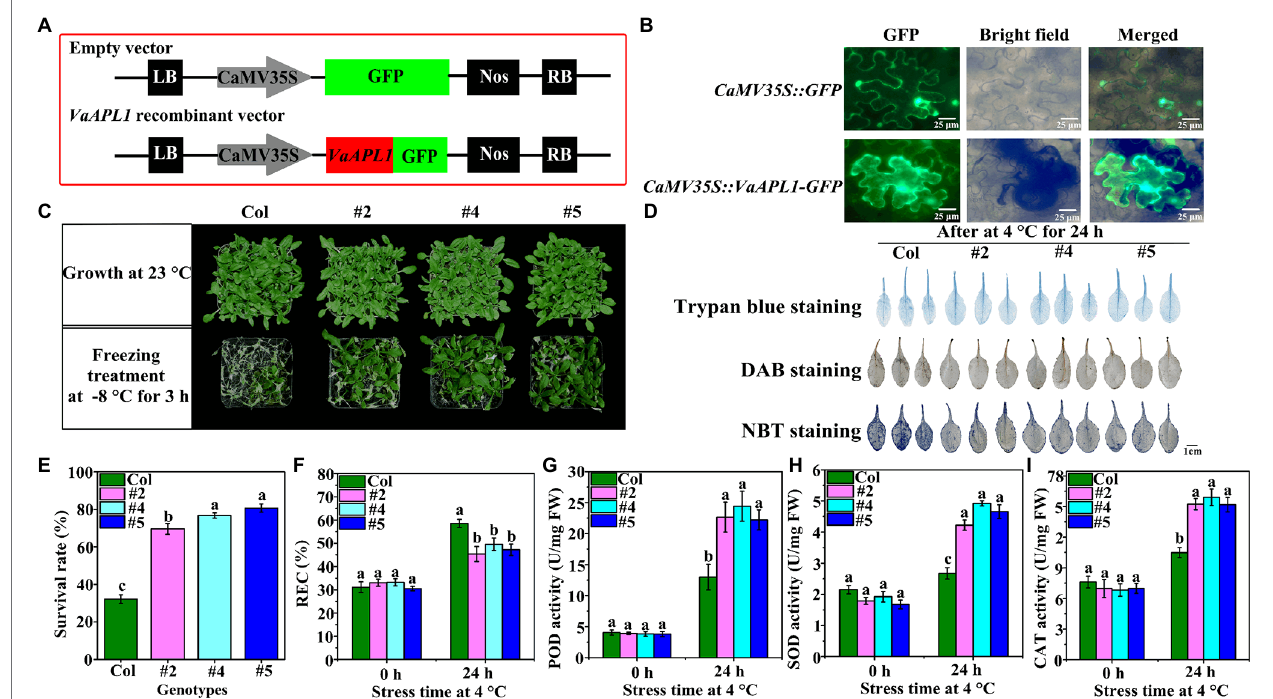
FIGURE 2 | Subcellular localization, survival rate, and changes in physiology and biochemistry of VaAPL1 -overexpressing A. thaliana plants. (A) The vector maps of subcellular localization. (B) Subcellular localization of VaAPL1 in leaf epidermal cells of tobacco. (C) Phenotypes of the Col and VaAPL1 -overexpressing A. thaliana plants (three individual transgenic lines were labeled #2, #4, and #5) after freezing treatments ( − 1 ° C for 2 h, and then cooled at a rate of 1 ° C·h − 1 until − 8 ° C for 3 h). (D) The leaves of Col and VaAPL1 -overexpressing A. thaliana plants were stained using DAB, NBT, and trypan blue. (E) Survival rate of Col and VaAPL1 - overexpressing A. thaliana plants after freezing treatment. (F) The change of relative electrolyte leakage (REC) in Col and VaAPL1 -overexpressing A. thaliana plants observed at 4 ° C after 0 h and 24 h. (G – I) The changes in POD, SOD, and CAT activities in Col and VaAPL1 -overexpressing A. thaliana plants at 4 ° C after 0 h and 24